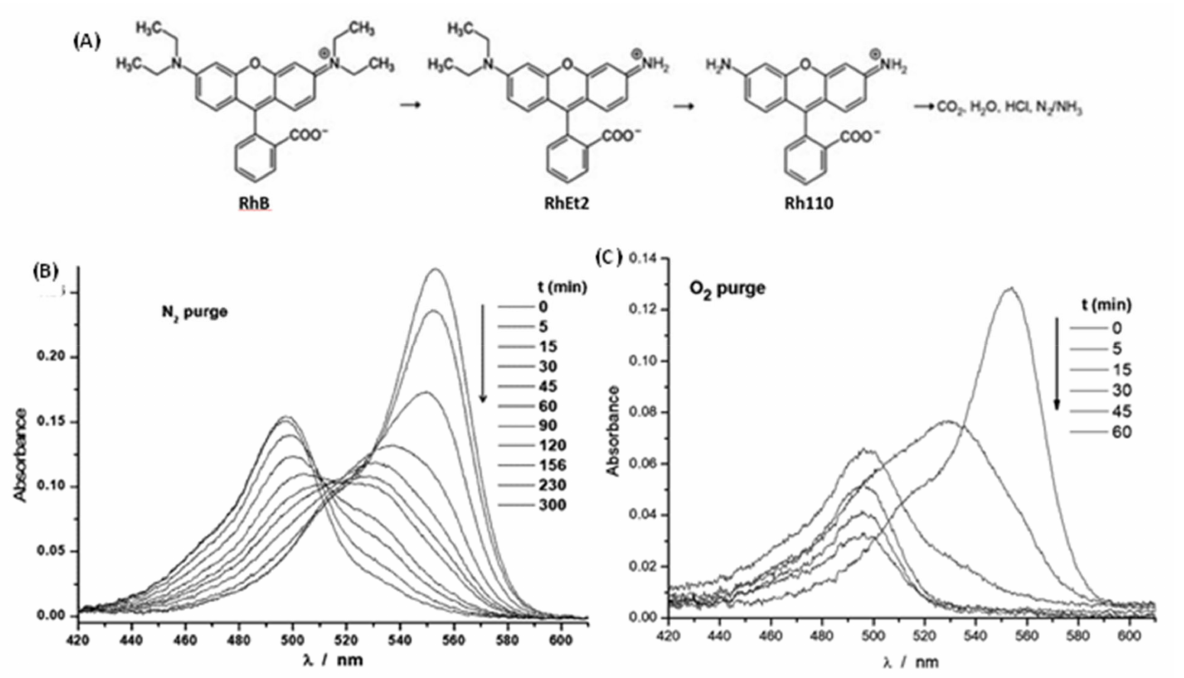
Figure 2. ( A ) Mechanism of the RhB degradation. Evolution of the absorption of light by the RhB dye (or by its intermediate degradation products) at different times under N 2 ( B ) or O 2 ( C ) flow (Adapted from Ref.